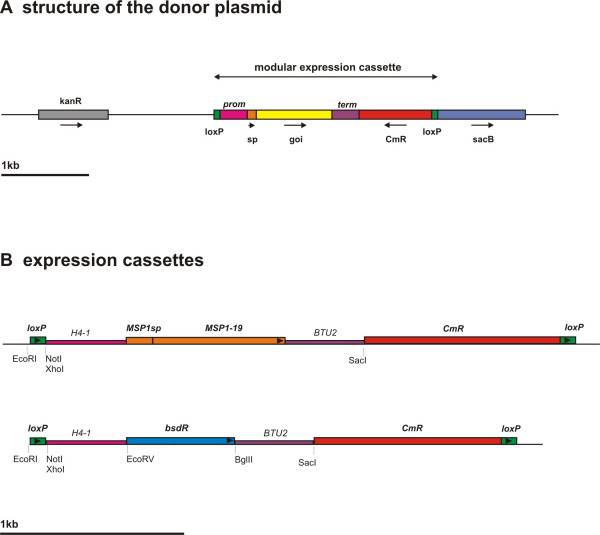
Structure of the used donor plasmids and expression cassettes. A: Scheme of the basis donor plasmid (linear structure) with its modular structure. The cassette allows the simple substitution of promoter, signal peptide (sp) gene of interest and terminator DNA sequences without loosing the flanking loxP sites due to unique restriction sites. B: "Floxed" (flanked by loxP) expression modules were used that encode an expression cassette for the MSP1 C-terminus gene (top) and the blasticidin resistance (bsdR, bottom) gene, respectively. All expression cassettes are flanked by a histone promoter (H4-1) and a beta tubulin terminator (BTU2).